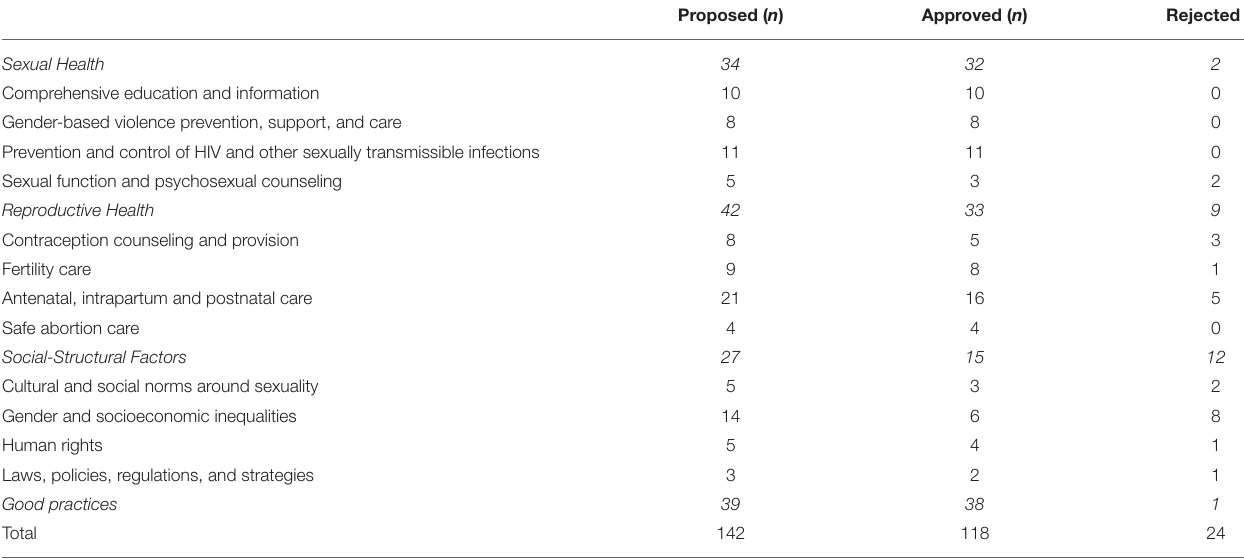
TABLE 2 | Number of indicators proposed, approved or rejected, by dimension and sub-dimension.